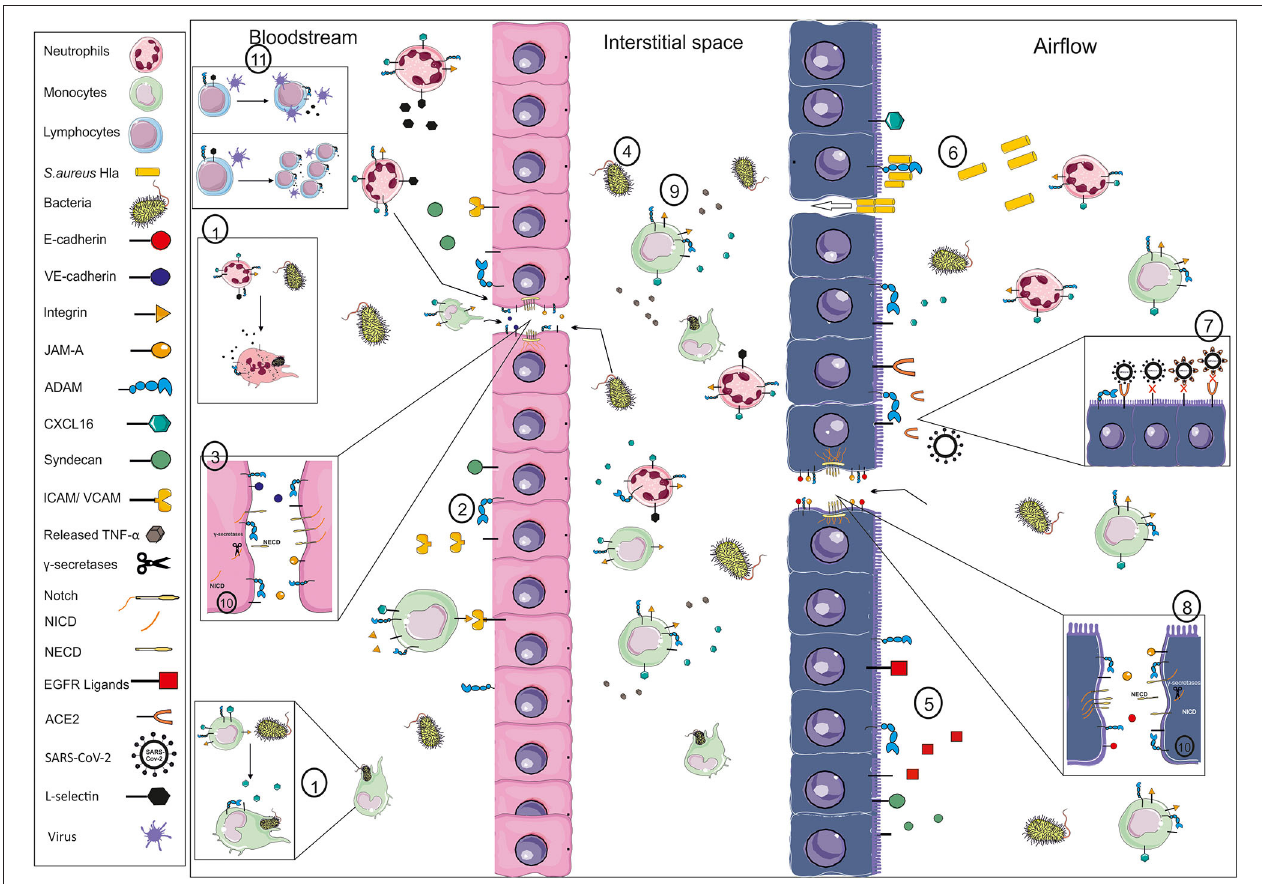
FIGURE 1 | Exemplary illustration of ADAM function in infection. Pathogens like bacteria and their toxins may enter the body as exemplarily shown for the blood stream (left side) and the respiratory system (right side). The first line of defense for systemically entering pathogens is circulating monocytes and neutrophils and the endothelial barrier. ADAM proteases are involved in phagocytosis through, e.g., cleavage of scavenger receptors like CXCL16 or the cleavage of L-selectin (1), in the activation of the endothelium changing the recruitment of inflammatory cells through cleavage of adhesion and junction molecules like ICAM, VCAM, JAM-A and VE-cadherin (2), resulting in gap formation and disturbance of the barrier integrity (3). Thereby, not only inflammatory cells are able to enter the interstitial space but also pathogens (4). Mucus production and the ciliary movement are the natural barrier for pathogens entering via the airflow, which are influenced by the release of EGFR ligands (5). The epithelium expresses several receptors for pathogens, such as ADAM10 in the case of S. aureus HIa (6) or ACE2 in the case of SARS-CoV2 (7). Cleavage of ACE2 could limit the viral uptake through lack of receptor and the blocking of circulating virus particles. Pore formation and cleavage of junction molecules like E-cadherin (8) result in crossing of the pathogens and infection of the tissue. The infection is may be cleared by resident or newly recruited leukocytes and a beneficial systemic response, e.g., initiated by TNF-alpha release (9). However, systemic spread of the pathogens, e.g., amplified by the cleavage of syndecans and Notch-1, and enhanced release of pro-inflammatory mediators may cause systemic effects like sepsis or cardiovascular failure. These events are not only orchestrated by α -secretase cleavage but further regulated through RIPing processes mediated by γ -secretases (10). Furthermore, systemic effects may be based on changes in cytotoxic T cell expansion or viral release from central memory T cells (11), both involving L-selectin shedding. These are only a few examples of the ADAMs’ impact in infection, which may differ in an organ- and site-specific manner. (VE-cadherin, vascular endothelial cadherin; JAM-A, junctional adhesion molecule A; ADAM, a disintegrin and metalloproteinase; ICAM, intercellular adhesion molecule; VCAM, vascular cell adhesion molecule; TNF, tumor necrosis factor; NICD, Notch intracellular domain; NECD, Notch ectodomain; EGFR, epidermal growth factor; ACE2, angiotensin converting enzyme 2).